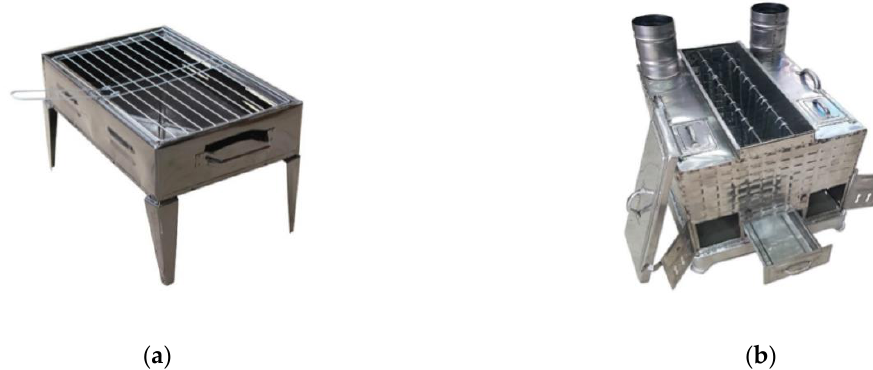
Figure 1. The photographs of the barbecues used in the current study. ( a ) Traditional barbecue for the direct method; ( b ) custom-made barbecue for the indirect method.